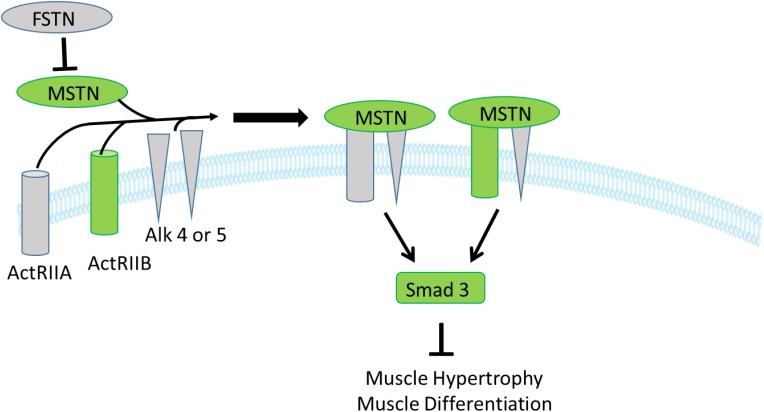
Myostatin signaling in muscle cells. Myostatin initially binds to one of the two activin type II receptors, and then binds to one or both of the activin-like kinase type I receptors 4 and 5 (ALK 4,5). Binding with myostatin activates the ALK4 and ALK 5 type I receptors resulting in phosphorylation of the transcription factors Smad 2,3 that leads to inhibition of muscle growth and differentiation. Gene expression of the molecules shown in green were downregulated in the high FE phenotype (upregulated in the low FE phenotype) whereas molecules in gray were not differentially expressed between the groups. The figure is adapted from Lee and Glass (2011).